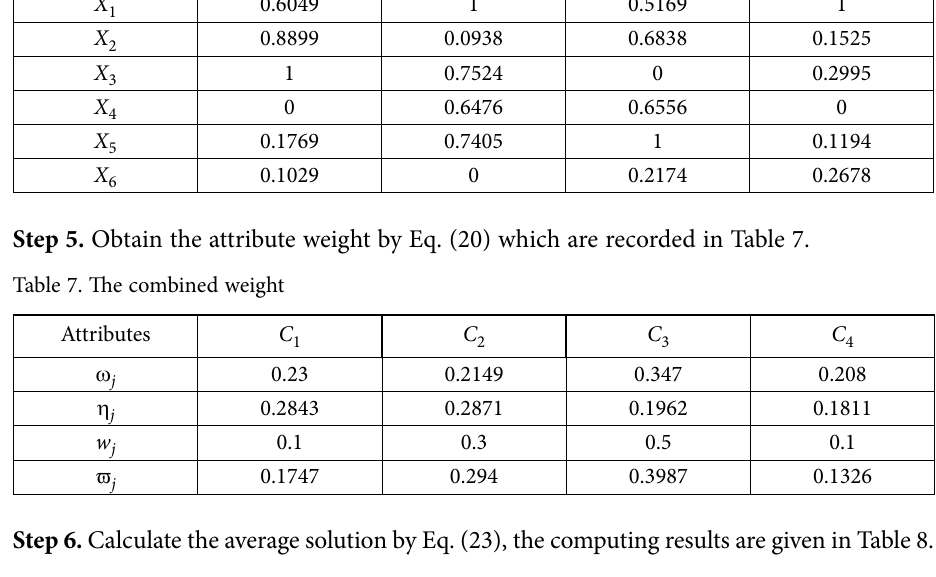
Table 6. The normalized score function decision-making matrix Q Alternatives